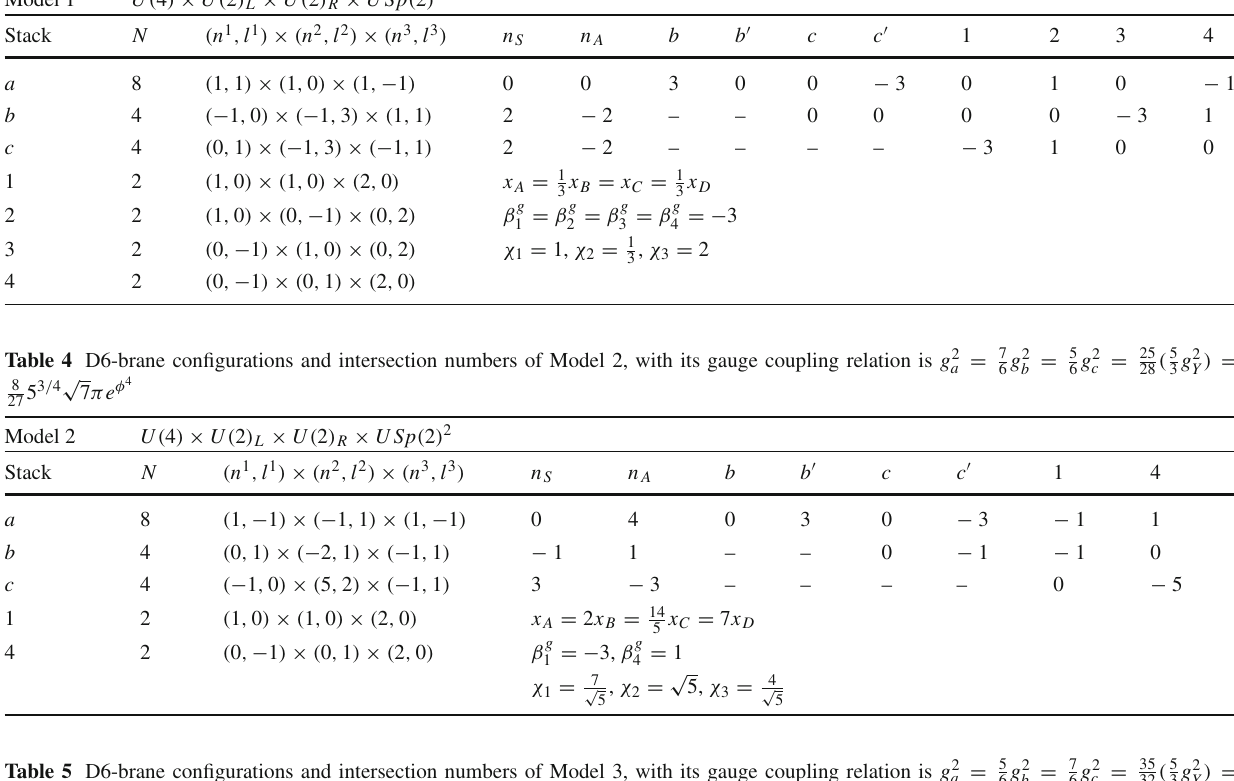
Table 3 D6-brane configurations and intersection numbers of Model 1, with its gauge coupling relation is g 2 a = g 2